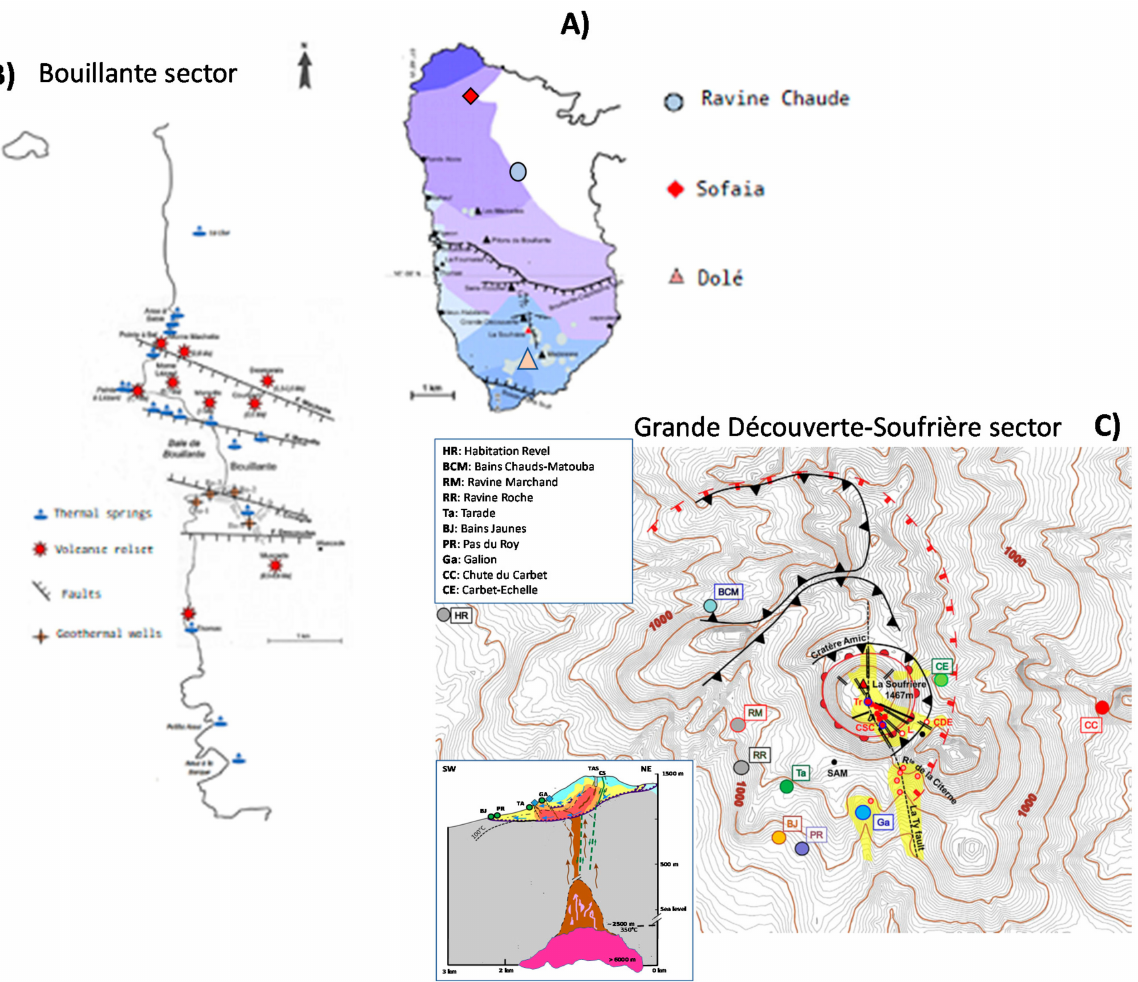
Figure 5. ( A ) Simplified geological map showing site location of Sofaia, Ravine Chaude et Dol é hot springs inland Basse- Terre (modified from Thinon et al. 2010 [61]). ( B ) Zoom on the west (downwind) coast, and the Bouillante sector (modified from Bouchot et al. 2009 [62]). ( C ) Hot springs located within La Soufri è re Grande Decouverte complex (modified after Villemant et al. 2014